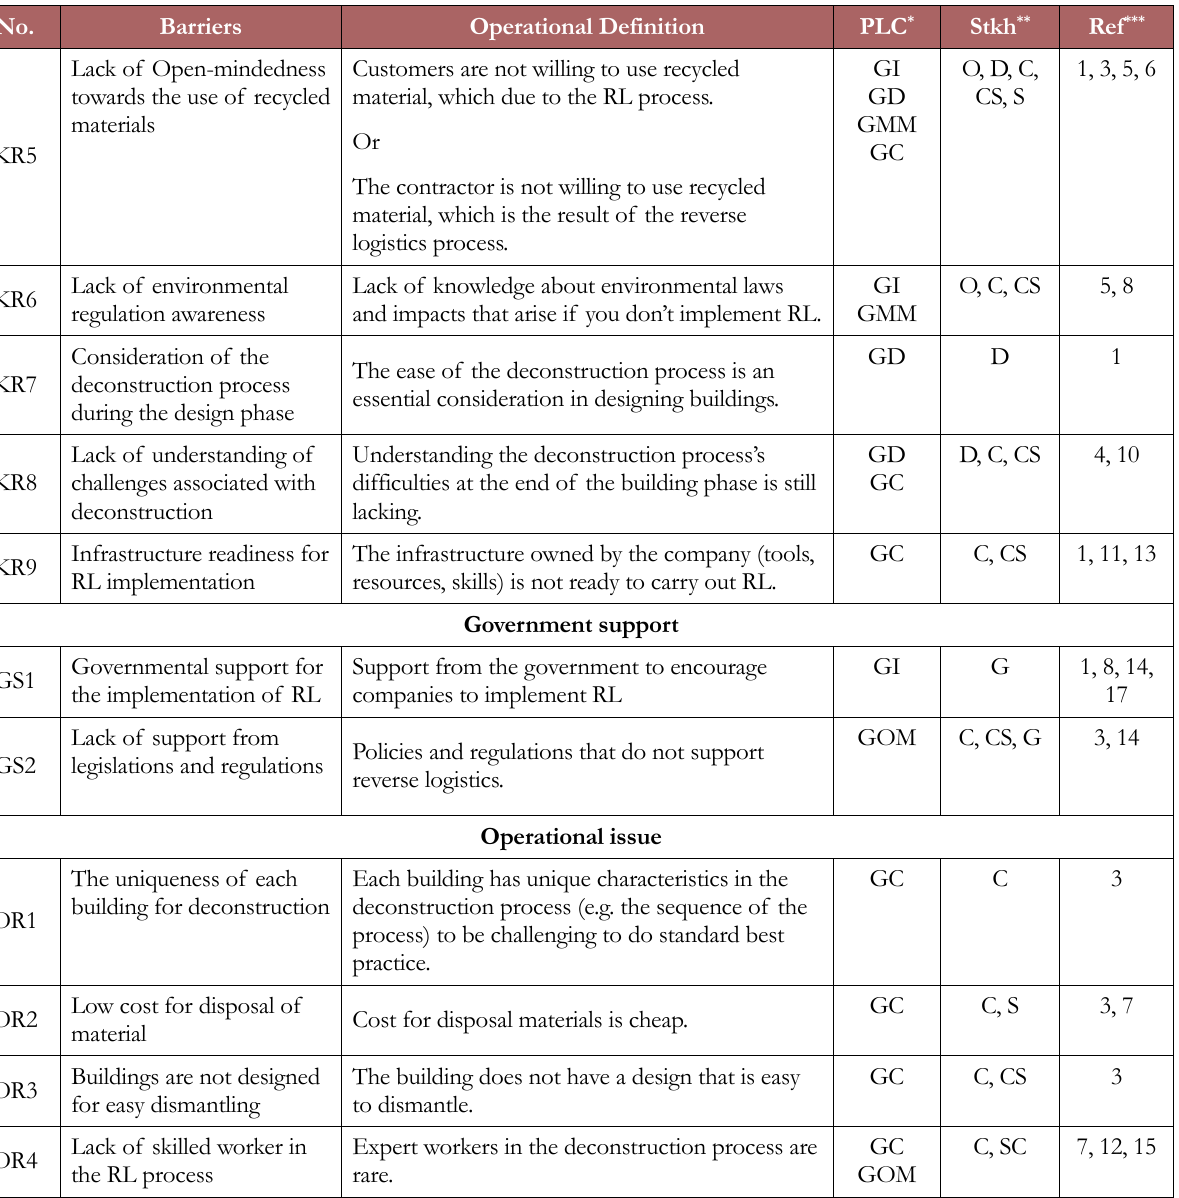
Table 2. Compilation of barriers from study